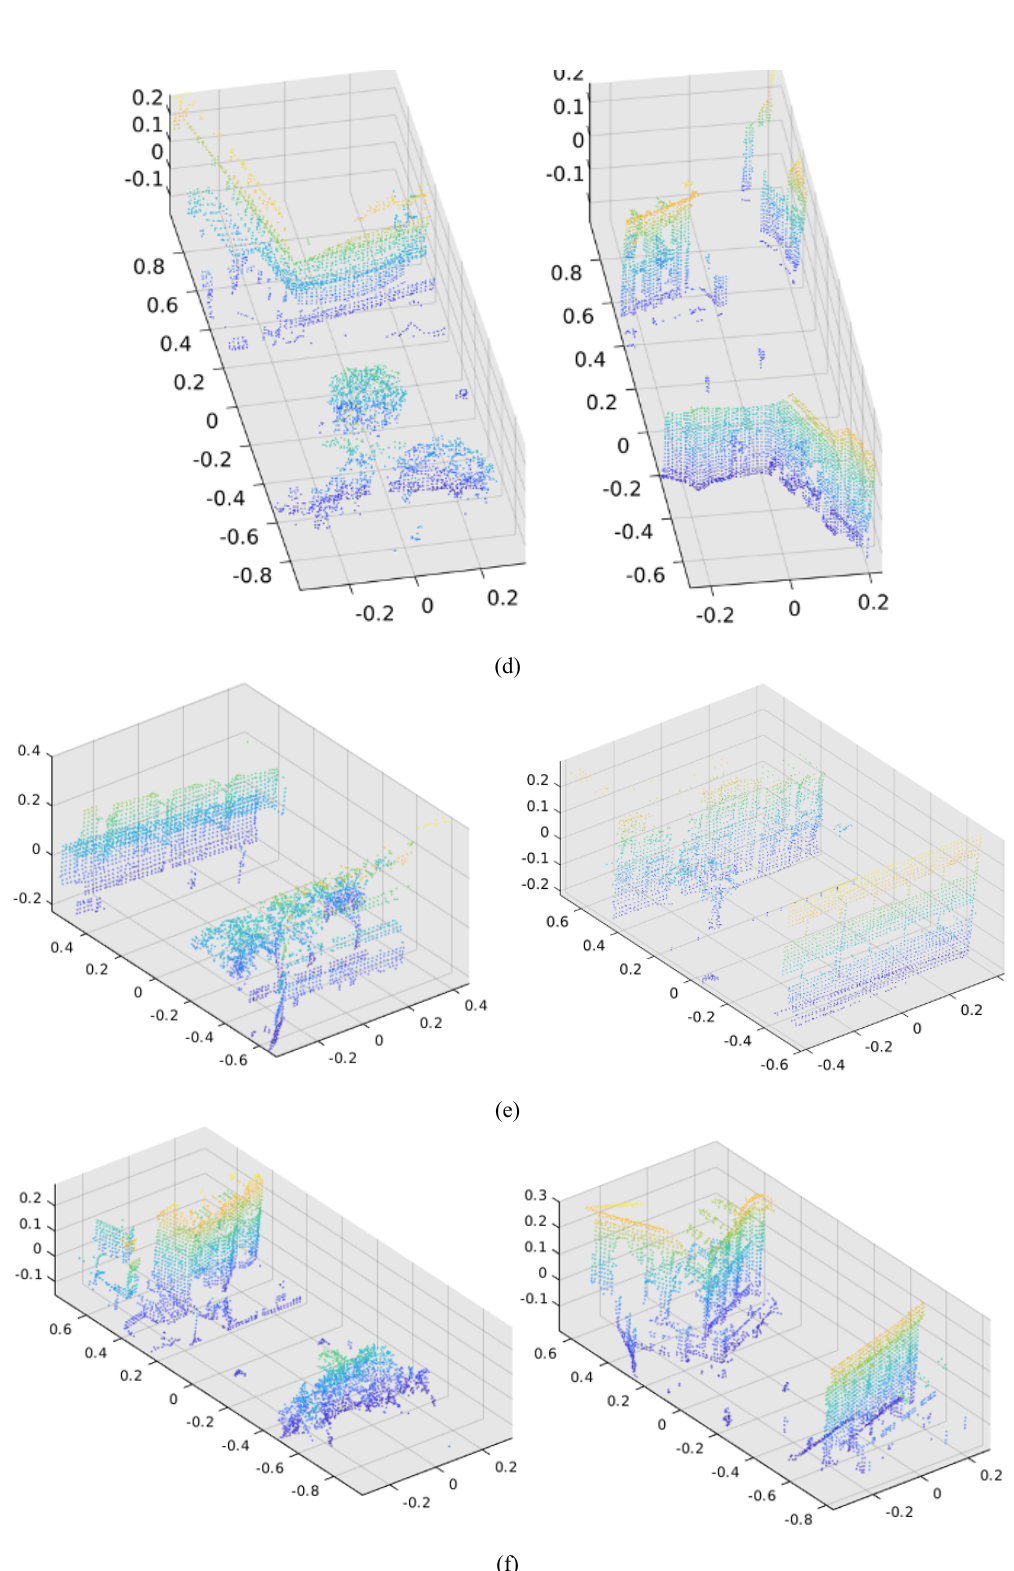
Figure 6. Examples of matching results, (a)~(c) are true positive matching, (d)~(f) are false positive